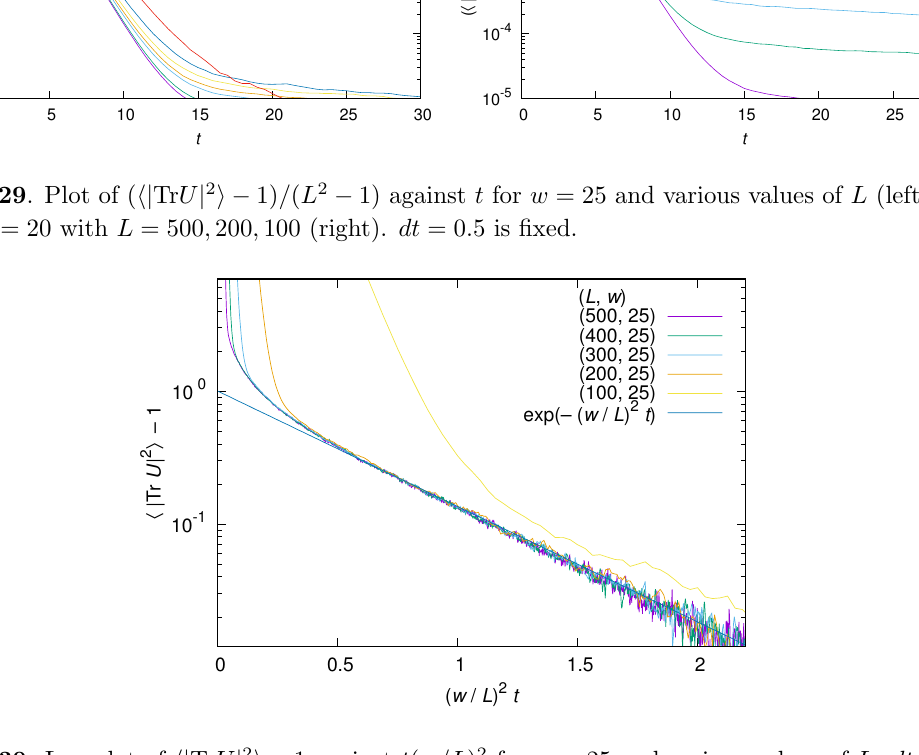
Figure 30 . Log plot of hj Tr U j 2 i (cid:0) 1 against t ( w=L ) 2 for w = 25 and various values of L . dt = 0 : 5 is (cid:12)xed. 10 5 samples have been used for L = 300 ; 200 ;